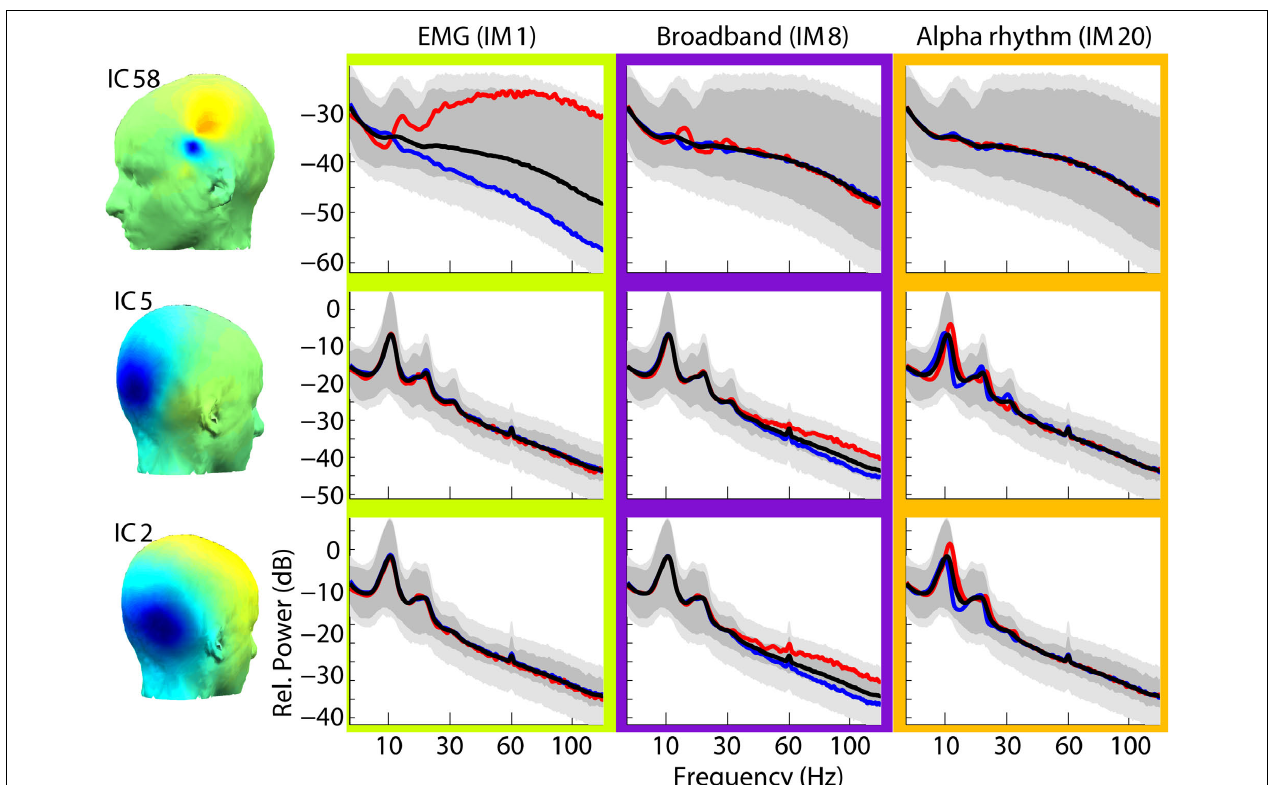
FIGURE 3 | Effects of brain and muscle modulators on independent component spectra. Maximal effects of three IMs (columns) on the power spectra of three ICs (rows) are shown via their maximal (red traces), minimal (blue traces), and mean (black traces) log-power spectra. Outer light grey limits represent the 1st and 99th percentiles of spectral variation across all the 2-s windows during the session. Dark grey areas represent the 1st and 99th